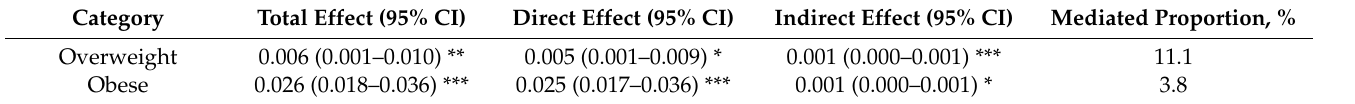
Table 4. Mediation effects of high mTG levels on the association between pre-pregnancy over- weight/obesity and fetal